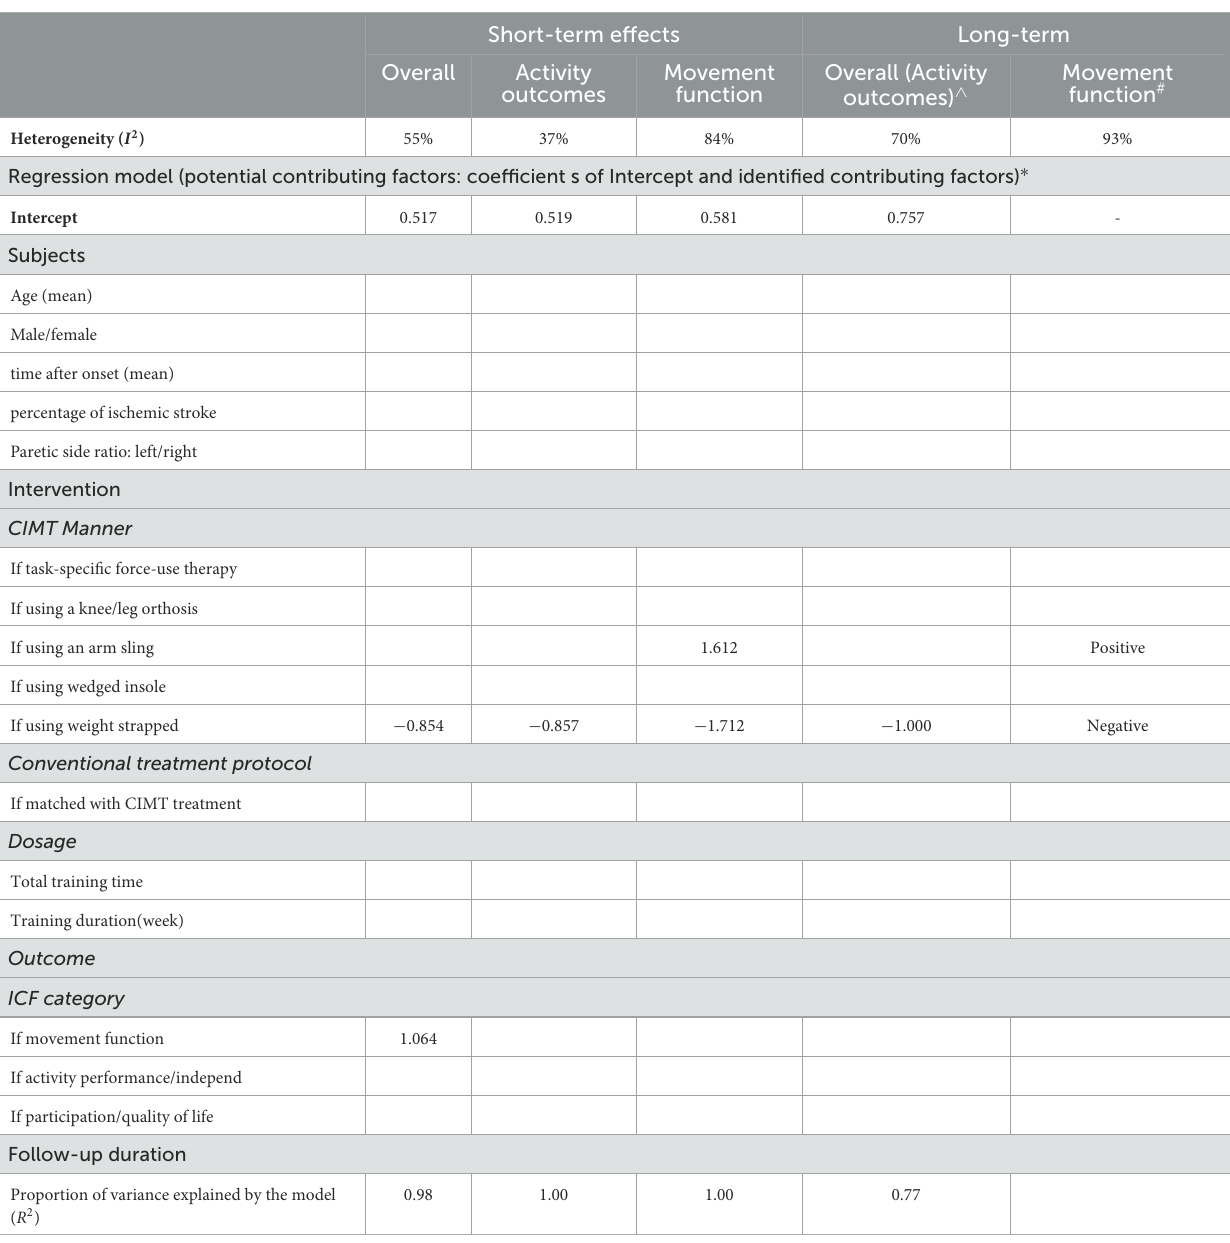
TABLE 4 Contributing factors to the heterogeneity of effect sizes of CIMT compared to conventional treatment in all